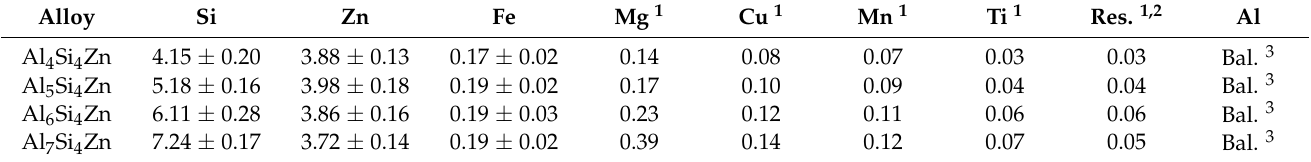
Table 1. Al X Si 4 Zn alloys (composition in wt.%) for use in thixoforming processes; standard uncer- tainties are shown as the deviation corresponding to a 0.95 confidence